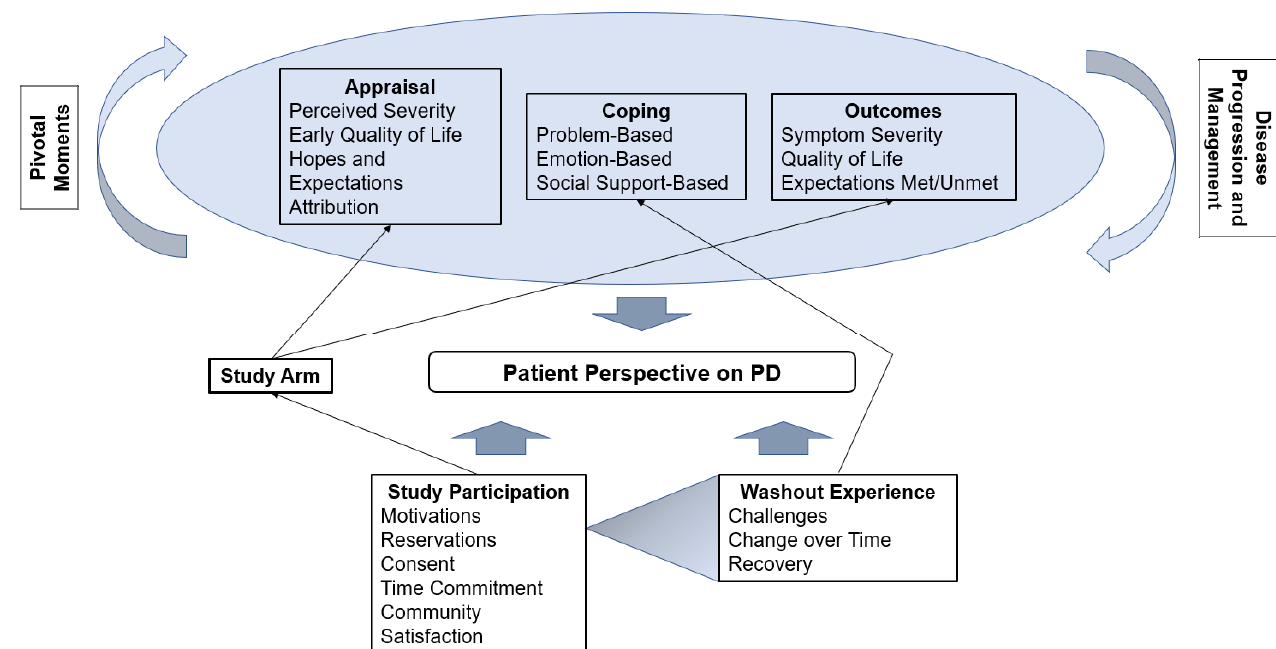
Figure 2. Conceptual framework . The early DBS trial participants’ perspective on their PD is deter- mined by a cycle of appraisal, coping, and outcomes. This cycle is influenced by their participation in the trial (study arm) as well as disease progression and management as well as pivotal moments of living with